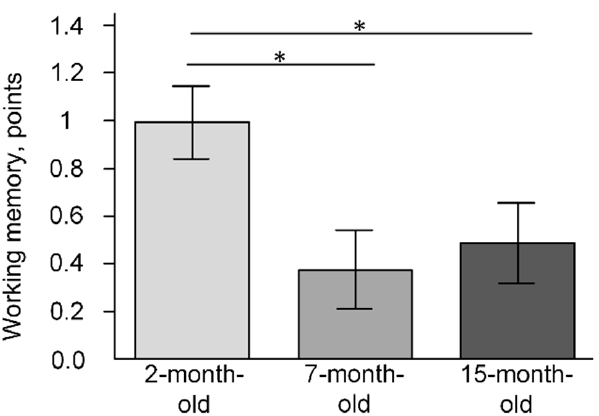
Figure 8. The results of the Morris water maze for working memory (points). * p < 0.05 differences between age groups were statistically significant according to the Mann–Whitney test. The 2-month- old mice (n = 9), 7-month-old mice (n = 9), 15-month-old mice (n = 9).